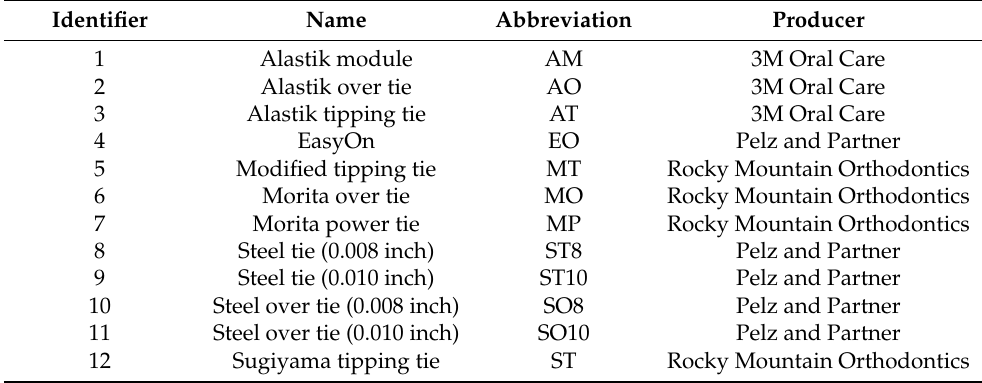
Morita over tie